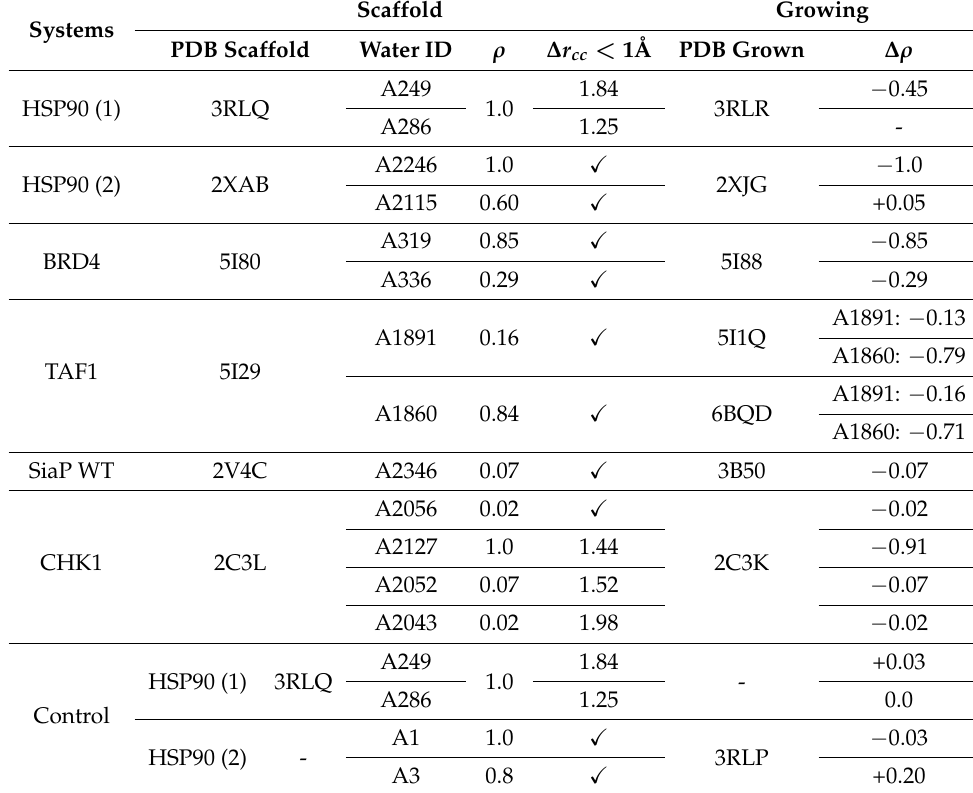
Table 1. Structural information of the results obtained for all the important water clusters in the simulated systems. The checkmark indicates that the distance between the detected water cluster’s oxygen and the crystallographic position of the water’s oxygen ( r cc ) is less than 1 ˚A. When one density extends over two different water IDs (i.e., HSP90(1), A249 and A286: ρ = 1.0) means that only one cluster was detected between the crystallographic positions of the original waters. Scaffold Growing Systems PDB Scaffold Water ID ρ ∆ r cc < 1 ˚A PDB Grown ∆ ρ A249 HSP90 (1) 3RLQ